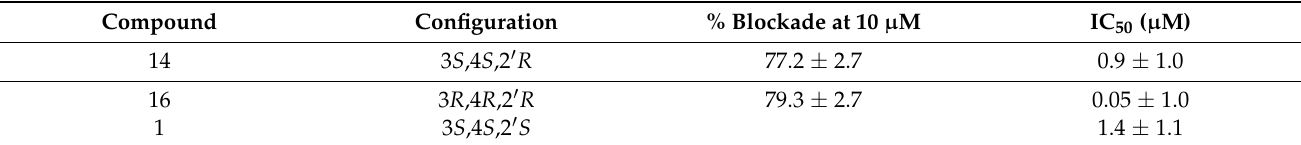
Table 3. Patch-clamp experiments (whole cell configuration in HEK293 cells expressing TRPM8 channels).